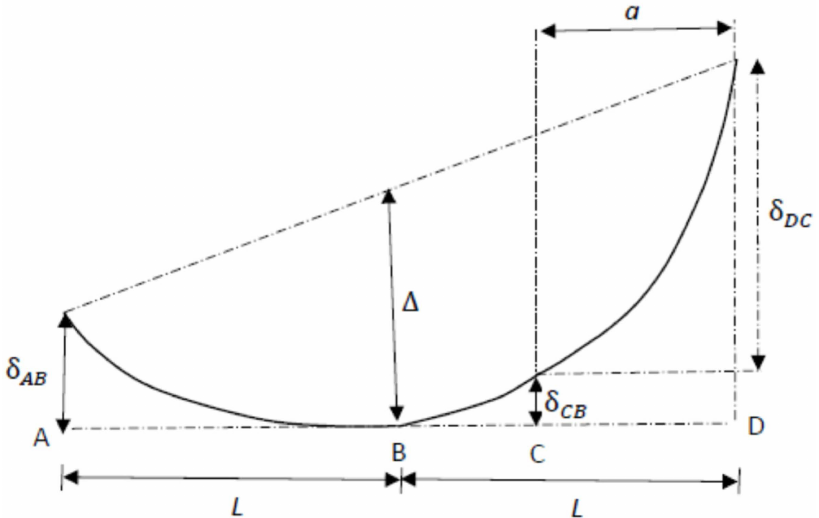
Figure 3. Schematic illustration of the deformation of the ENF specimen under three-point bending